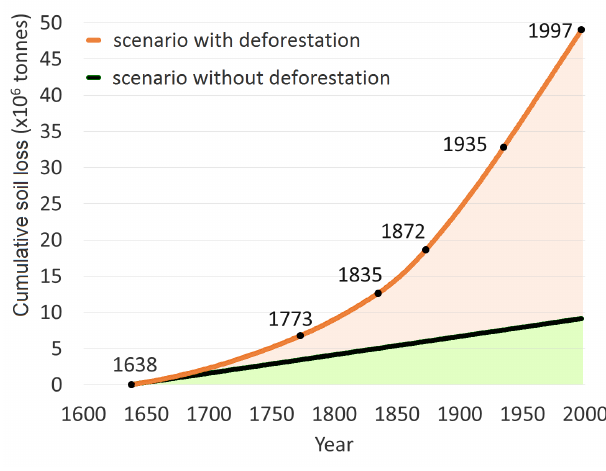
Fig. 6. Cumulative modeled soil loss on Mauritius for a scenario with and without deforestation. To calculate cumulative soil loss for the scenario without deforestation, the soil loss in 1638 was used as the annual soil loss rate. In the scenario with deforestation, linear interpolation was used to reconstruct soil loss rates for the intermediate years between the modeled